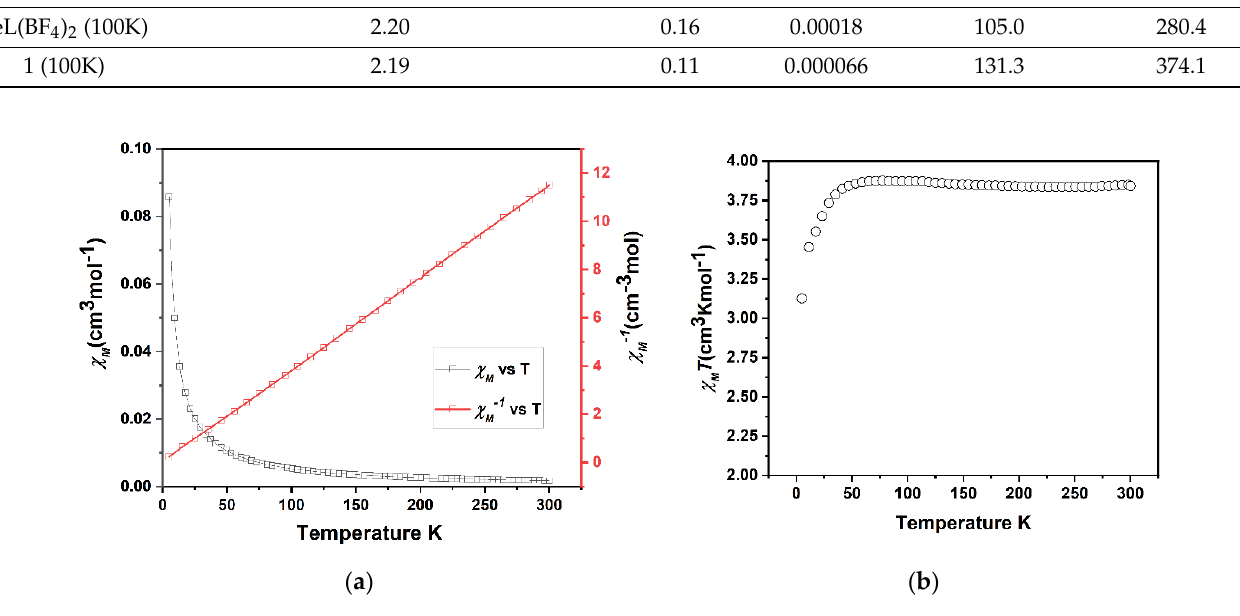
Figure 3. ( a ) A combined plot of the molar magnetic susceptibility (χ M ) and inverse magnetic susceptibility (χ M-1 ) of FeL(BF 4 ) 2 ( 3 ) against temperature. ( b ) A plot of the magnetic susceptibility (χ M T ) vs. T per metalloligand. Both plots are indicative of the presence of HS (paramagnetic) Fe(II).